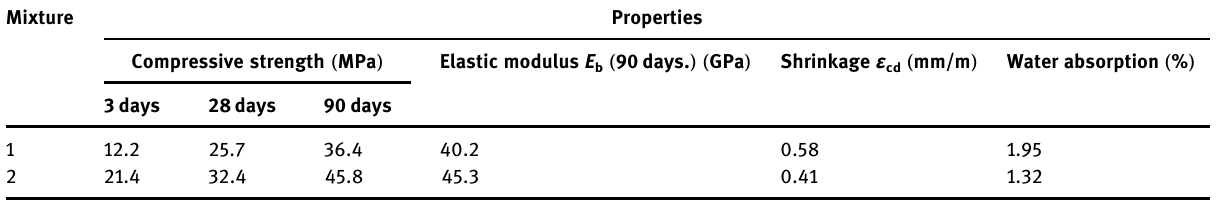
Table 19: Properties of nano - modi fi ed concrete Mixture